Question: What style of plot is this figure drawn as?
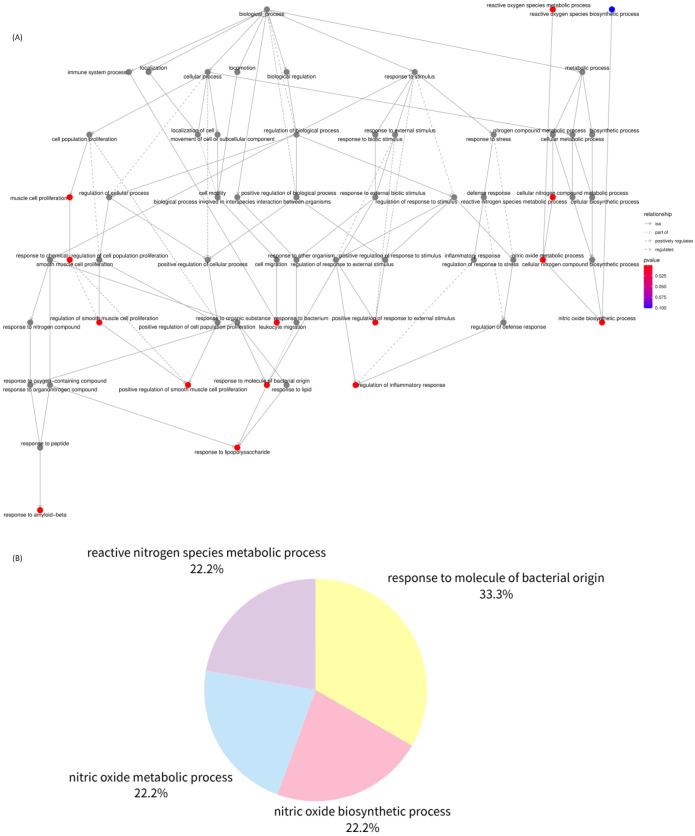
Answer: pie